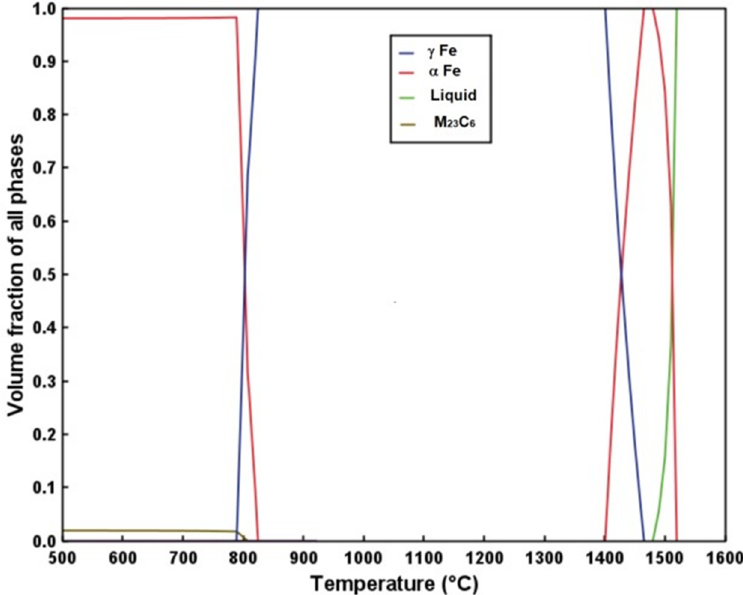
Figure 1. Plot of volume fraction of equilibrium phases against temperature.